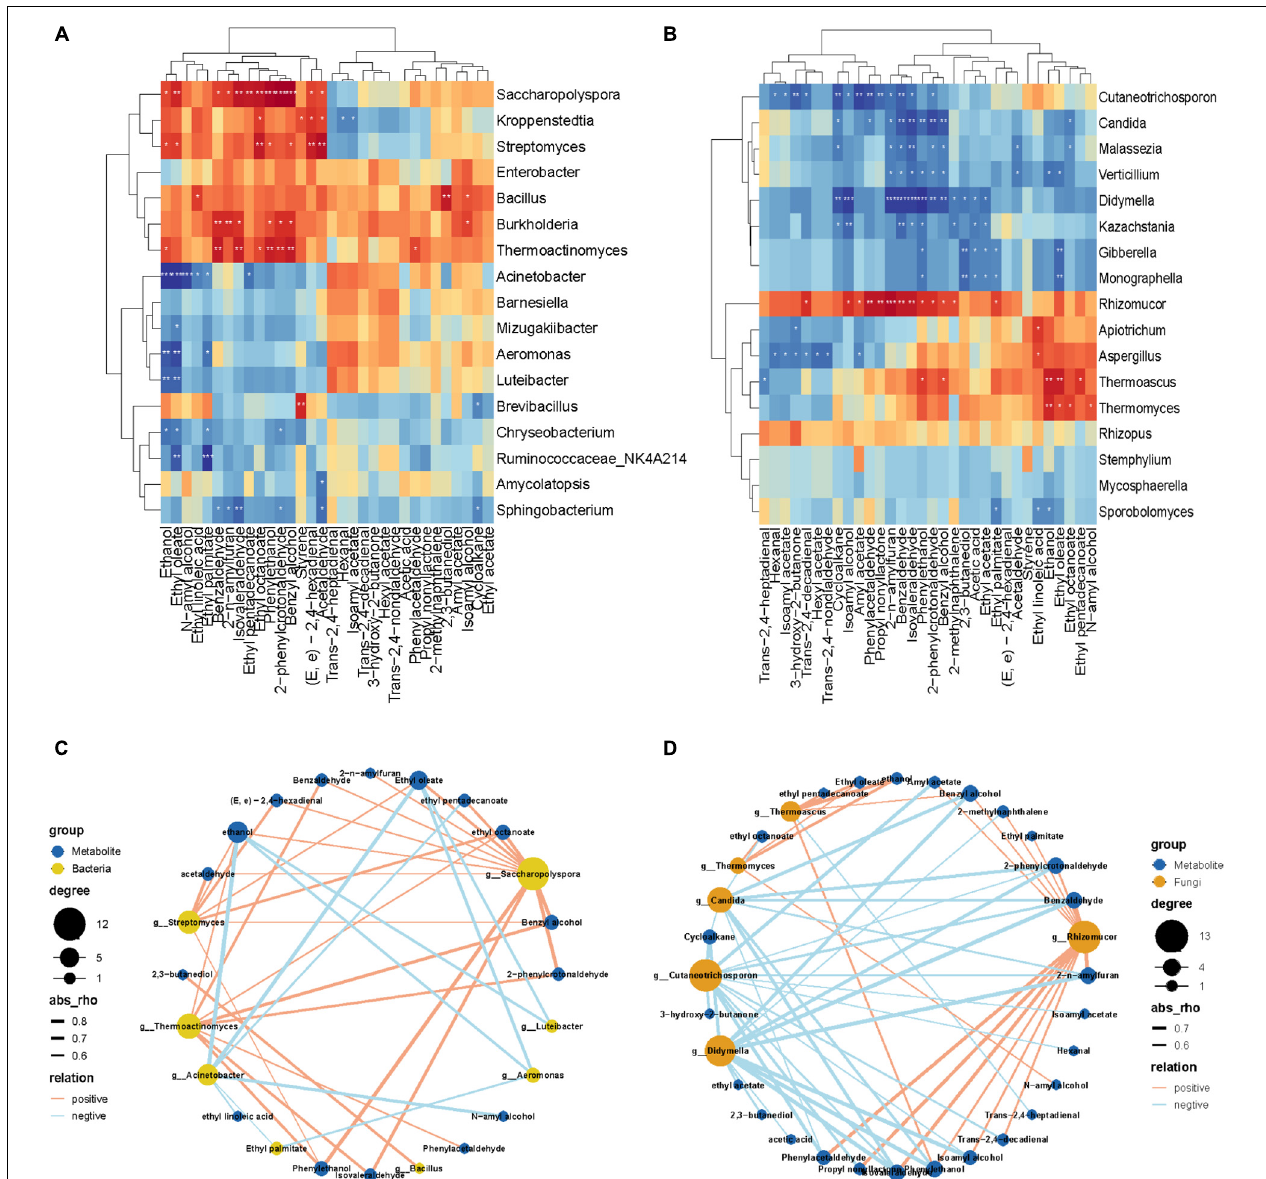
FIGURE 6 | Heatmaps of Spearman correlations between dominant (A) bacterial and (B) fungal genera and differential metabolites during the fermentation process. Levels of significance are shown as follows: *0.01 < p ≤ 0.05; **0.001 < p ≤ 0.01,*** p ≤ 0.001. The co-occurrence network diagram of a highly significant correlation between differential metabolites and differential bacteria (C) and fungi (D)